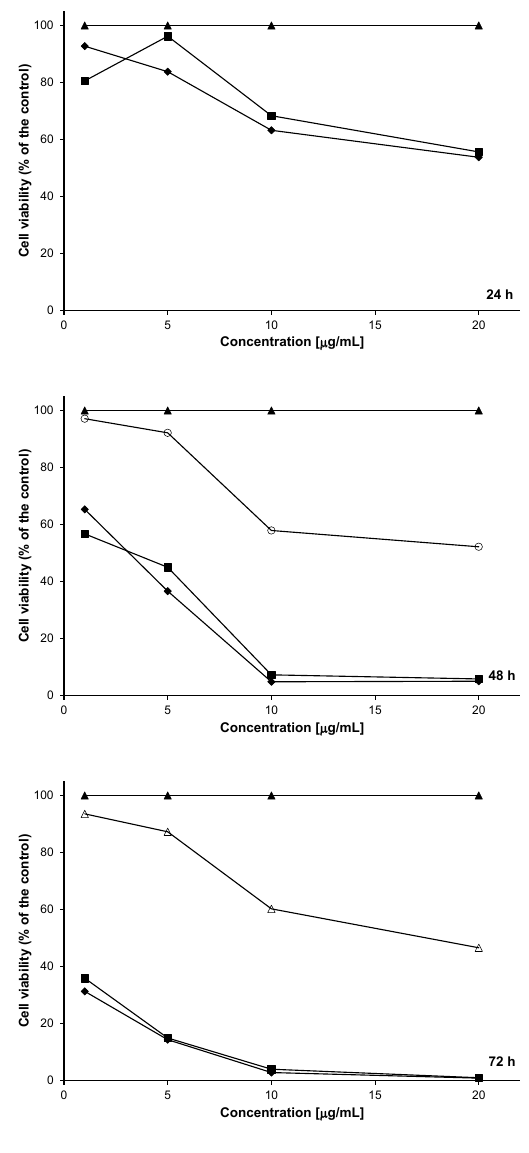
Figure 5: Effect of Monensin (∆), DMSO (○) and complexes 1 - 2 (■,